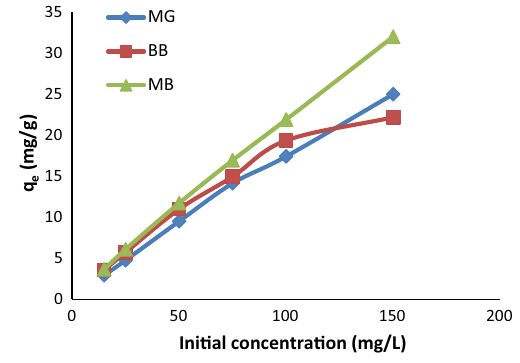
Fig. 1 Effect of concentration on adsorption of